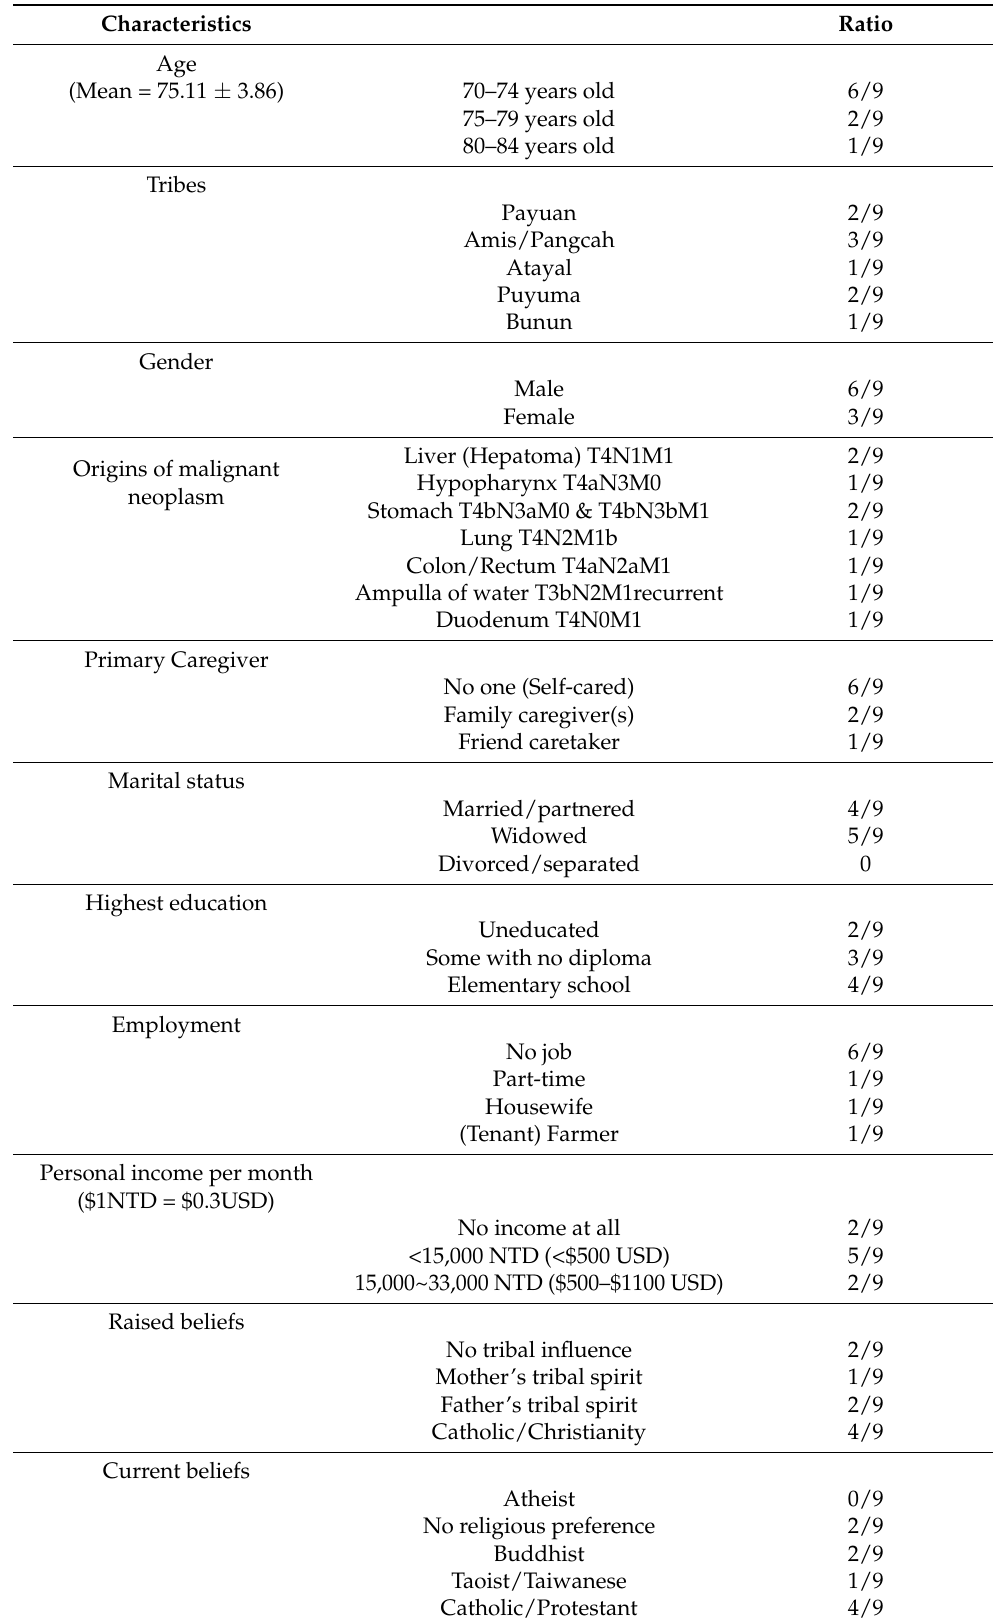
Table 1. Demographical characteristics of the older indigenous sample ( n =